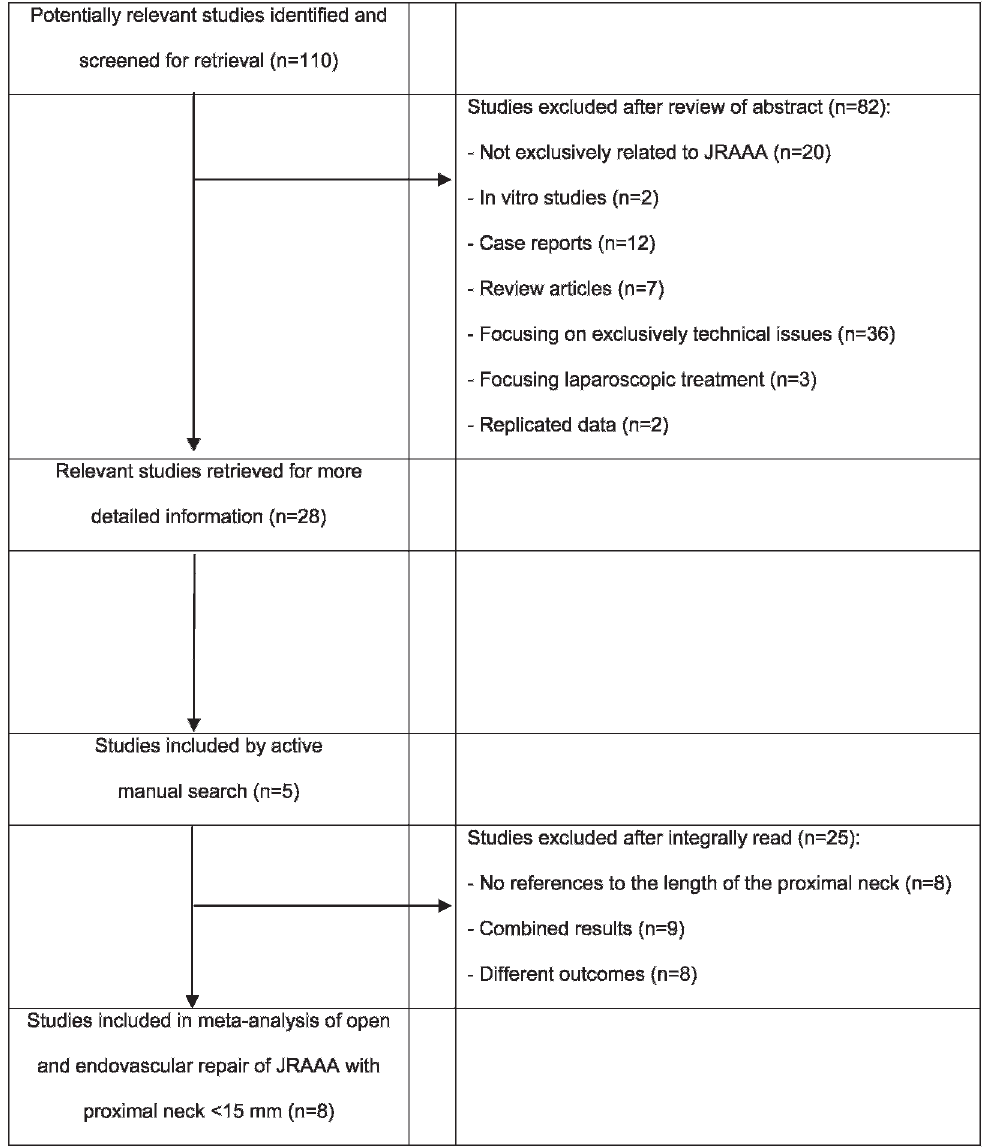
Figure 1 - PRISMA flow diagram for the meta-analysis of open and endovascular repair of JRAAA with proximal neck , 15